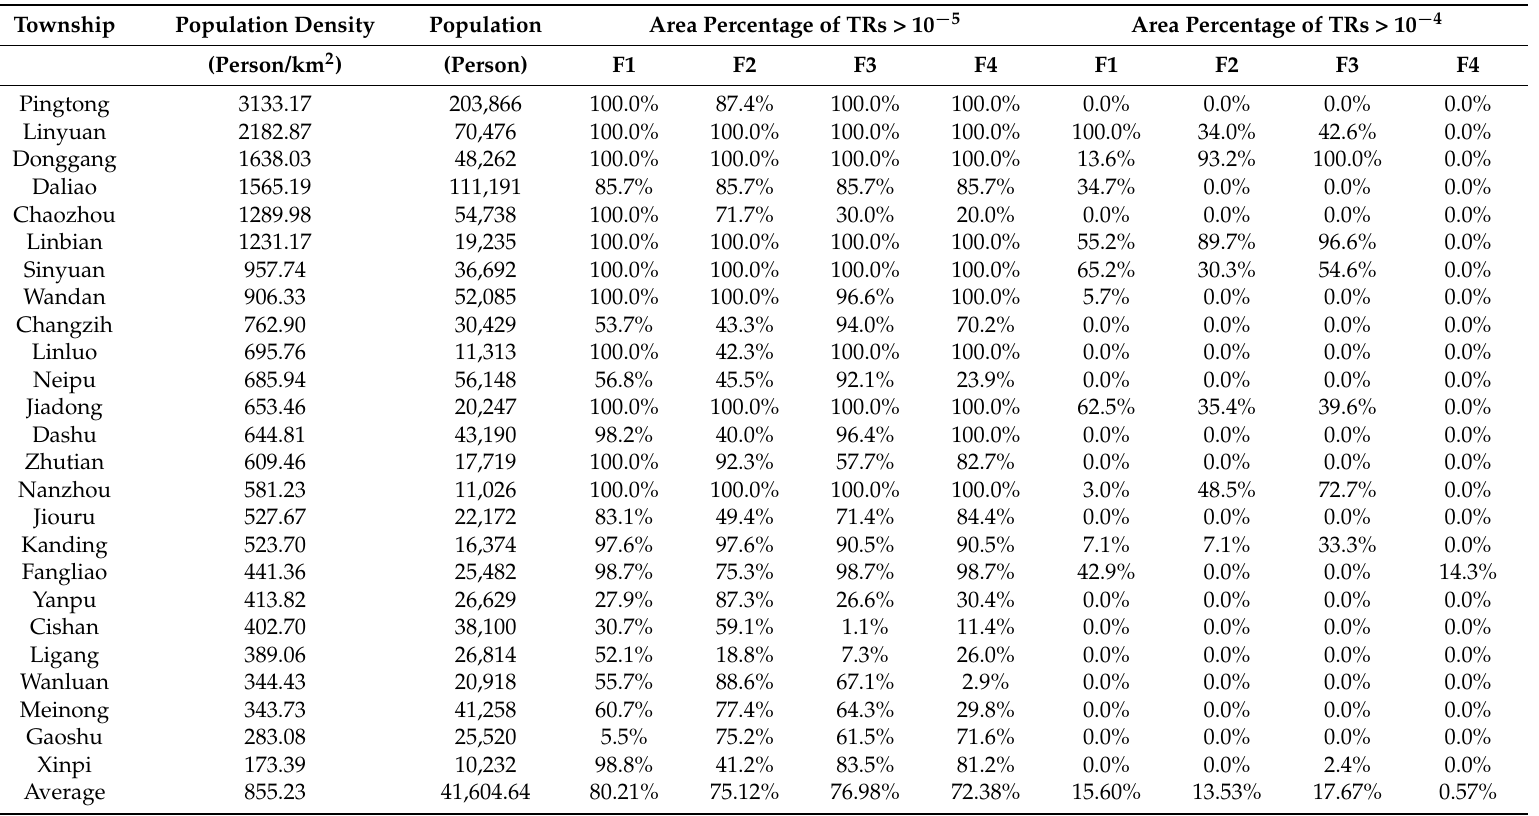
Table 3. Area percentage (%) of target cancer risk exceeding 10 − 5 and 10 − 4 in individual townships on the Pingtung